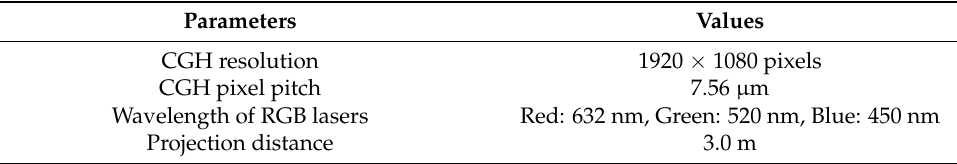
Table 1. Calculation parameters.